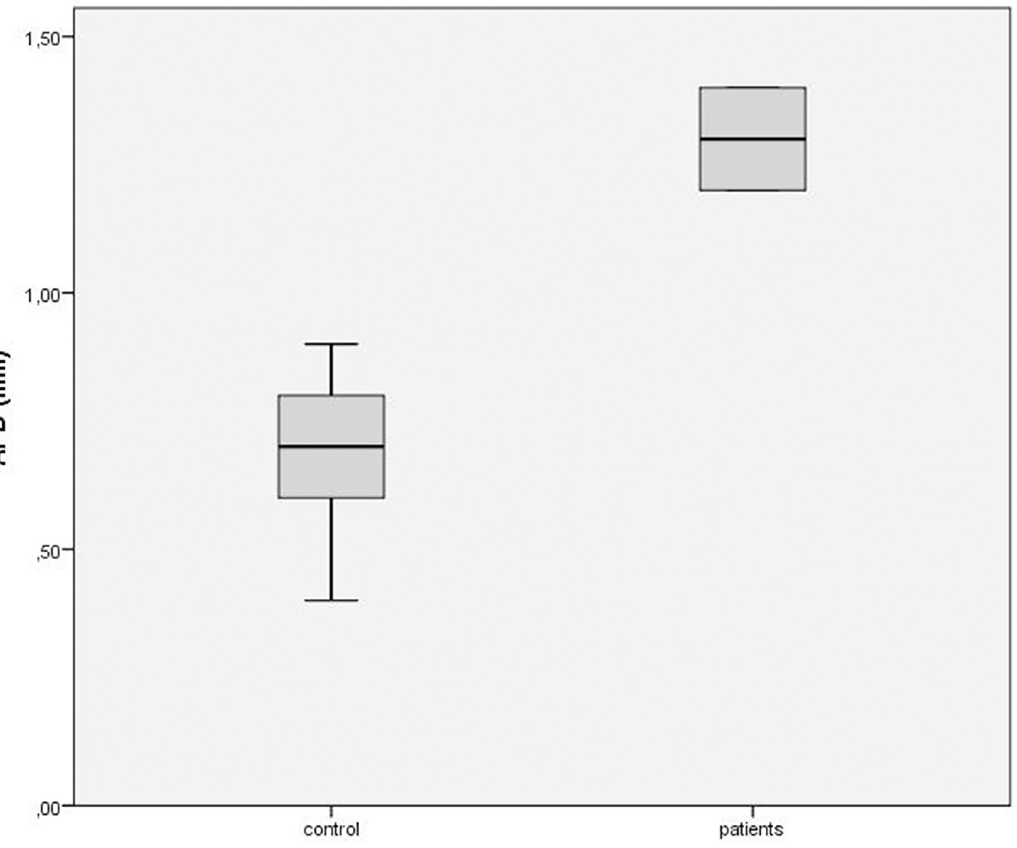
Fig 2. Antero-posterior diameter (APD) of posterior interosseous nerve (PIN). Antero-posterior diameter (APD) of PIN in four patients shows a significant swelling of the PIN in comparison to controls. ** p < 0.001